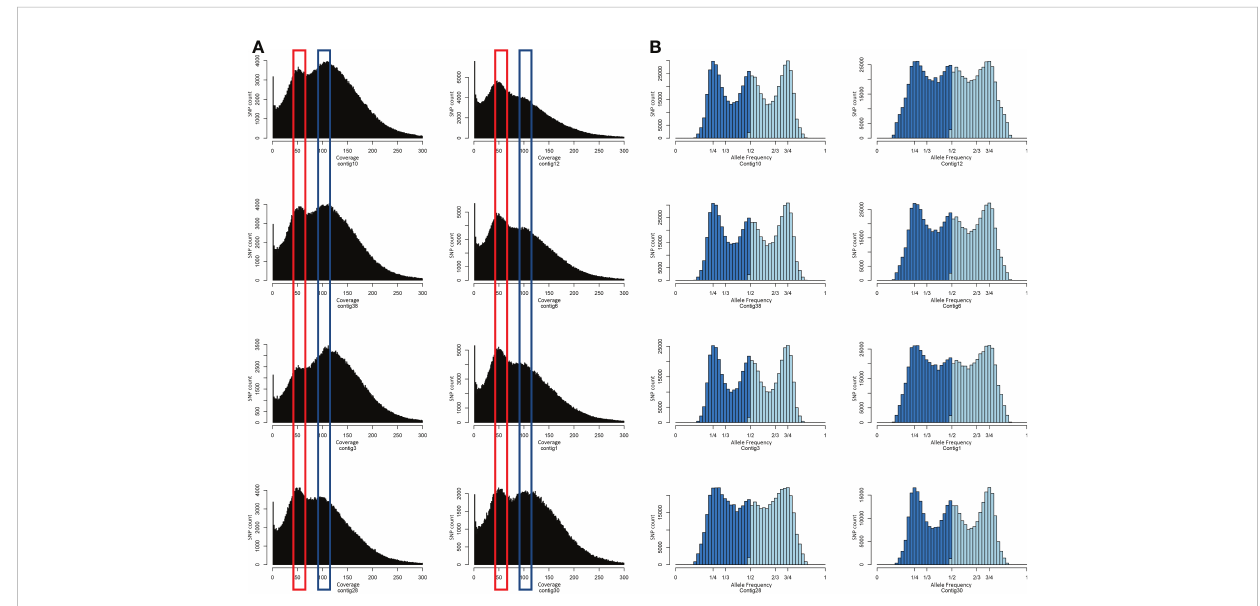
FIGURE 6 Tanganyika INTA SNP coverage (A) and allele frequency distribution (B) on the eight longest chromosomes of the Victoria genome assembly. (A) The y-axis represents the number of SNP and the x-axis the SNP coverage. The red and blue shapes highlight the two peaks around 50× and 100× showing the SNPs with diploid and tetraploid coverage. (B) The y-axis represents the number of SNP and the x-axis the allele frequency.